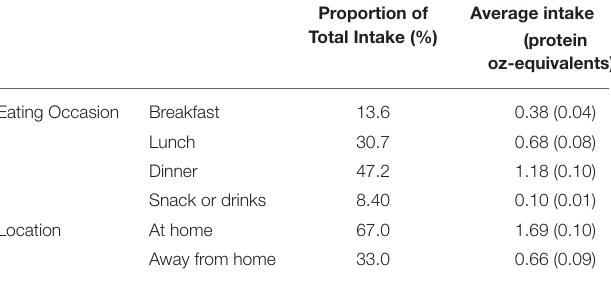
TABLE 3 | Percentage and the amount of legume intake by eating occasion and location among 990 adults in NHANES who reported consuming legumes in the last